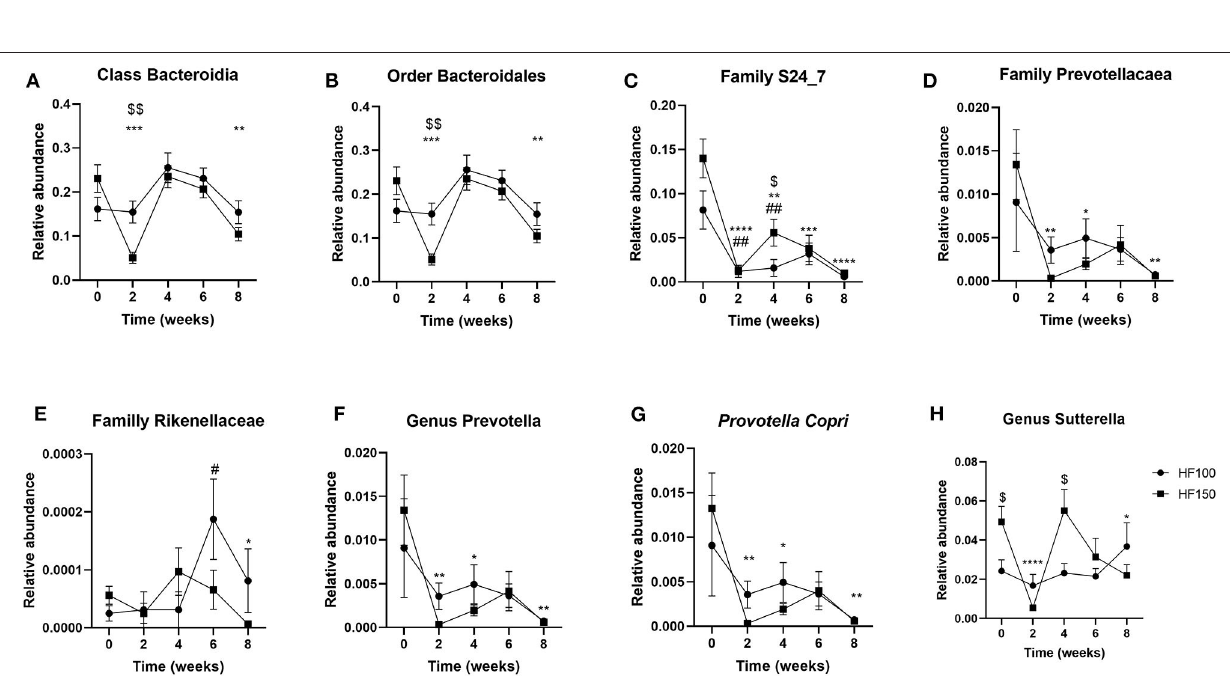
FIGURE 5 | Relative abundance of the fecal bacterial groups belonging to the phylum Bacteroidetes [ (A) Bacteroidia, (B) Bacteroidales, (C) S24_7, (D) Prevotellacaea, (E) Rikenellaceae, (F) Prevotella, and (G) Prevotella Copri] and Proteobacteria [ (H) Sutterella] in dogs fed the high-fat diet at maintenance (HF-100; n = 8) and at 150% maintenance (HF-150; n = 16) for 8 weeks. Data are mean ± SEM. * P < 0.05, ** P < 0.01, *** P < 0.001, **** P < 0.0001 during the HF-150 diet vs. week 0, # P < 0.05, ## P < 0.01 at week 2, 4, and 6 vs. week 0 for HF-100 group, $ P < 0.05, $$ P < 0.01 HF-150 vs. HF-100 at weeks 0, 2, and